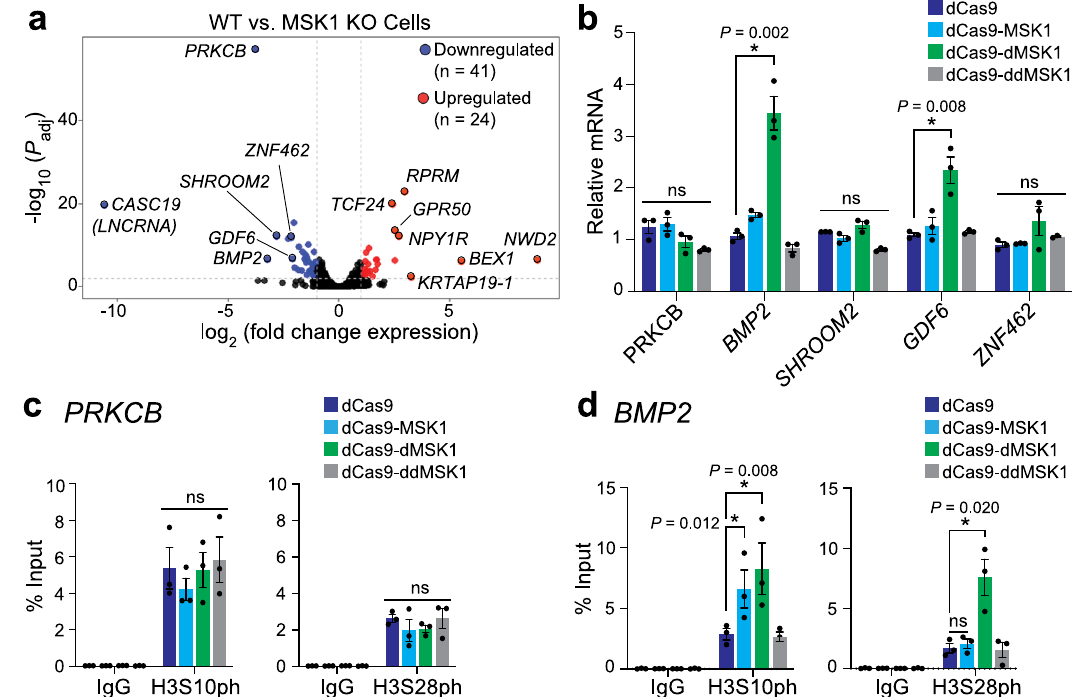
Fig. 2 dCas9-dMSK1 activates natural MSK1 target genes. a Differentially expressed genes in MSK1 knockout HEK293T cell lines compared to WT HEK293T cells are shown (blue circles, downregulated genes; red circles, upregulated genes). Data were analyzed using the Wald test and the adjusted P value ( P fi ve downregulated genes were measured by RT-qPCR adj ) was calculated using the Benjamini and Hochberg method. b mRNA levels for the top at 72 h post-transfection of indicated dCas9-fusion proteins (or dCas9 control) and corresponding gRNAs. c , d ChIP-qPCR for H3S10ph and H3S28ph at the PRKCB and BMP2 promoters, respectively, 72 h post-transfection with the indicated dCas9-fusion proteins or dCas9 control. Two-sided t -test, * P < 0.05; n = 3 independent experiments for panels ( b – d ); error bars; s.e.m.; ns, not signi fi cant. Source data are available in the Source data fi